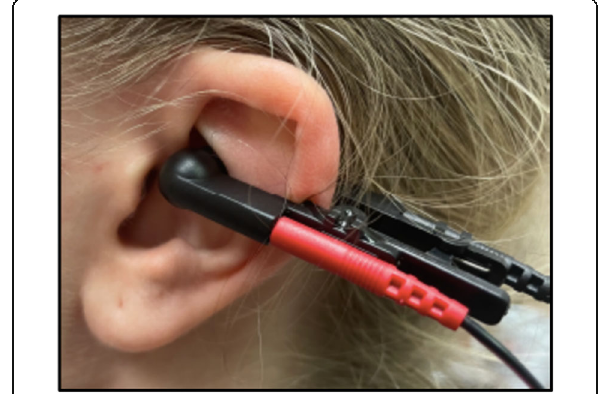
Fig. 1 Ear-clip at the left cymba